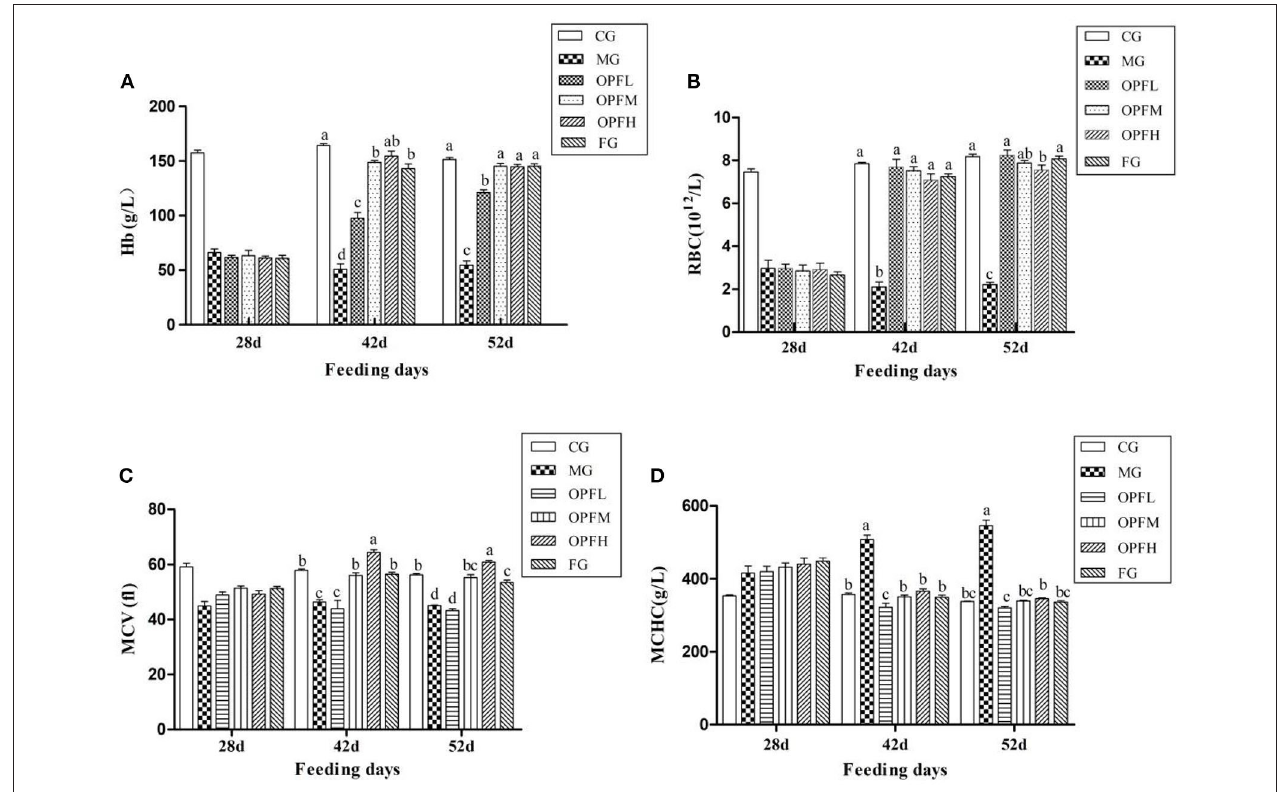
FIGURE 5 | Effect of different doses of OP-Fe 2 + and FeCl 2 on (A) Hb, (B) RBC, (C) MCV, and (D) MCHC in IDA rats. Different letters indicate a significant difference between different groups in the same period ( p < 0.05). The same letter in different groups indicates the absence of a statistical difference between these groups in the same period ( p > 0.05). 28 d refers to the time when the IDA model was successfully established and has not yet been given treatment; 42 d refers to the second week of treatment with OP-Fe 2 + and FeCl 2 ; 52 d refers to the 3 weeks of treatment with OP-Fe 2 + and FeCl 2